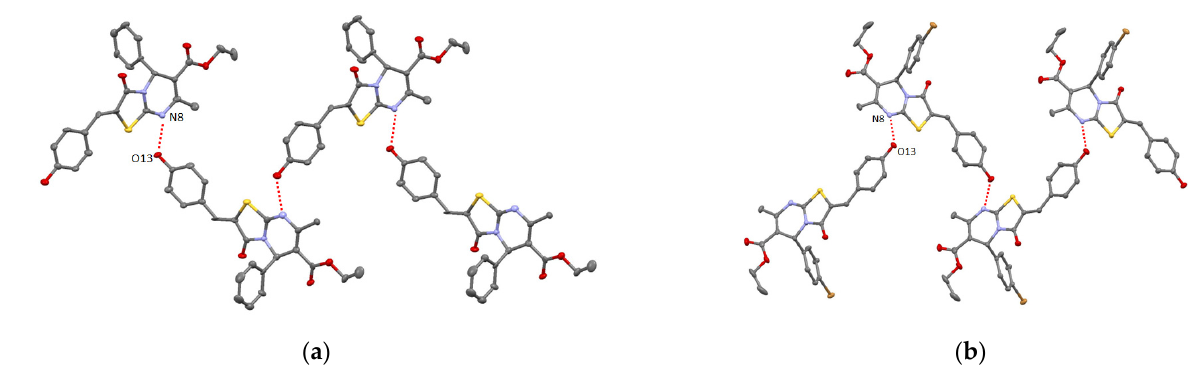
Figure 7. ORTEP view of supramolecular 1D homochiral chains formation of 13 ( a ) and 14 ( b ). The ellipsoids are presented with 50% probability, H ‐ atoms are omitted for clarity.